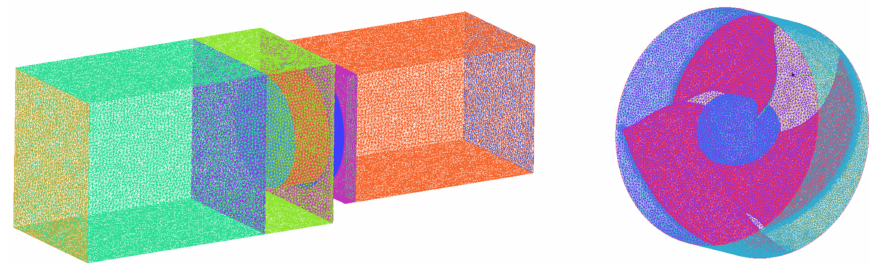
Figure 5. Schematic of grid